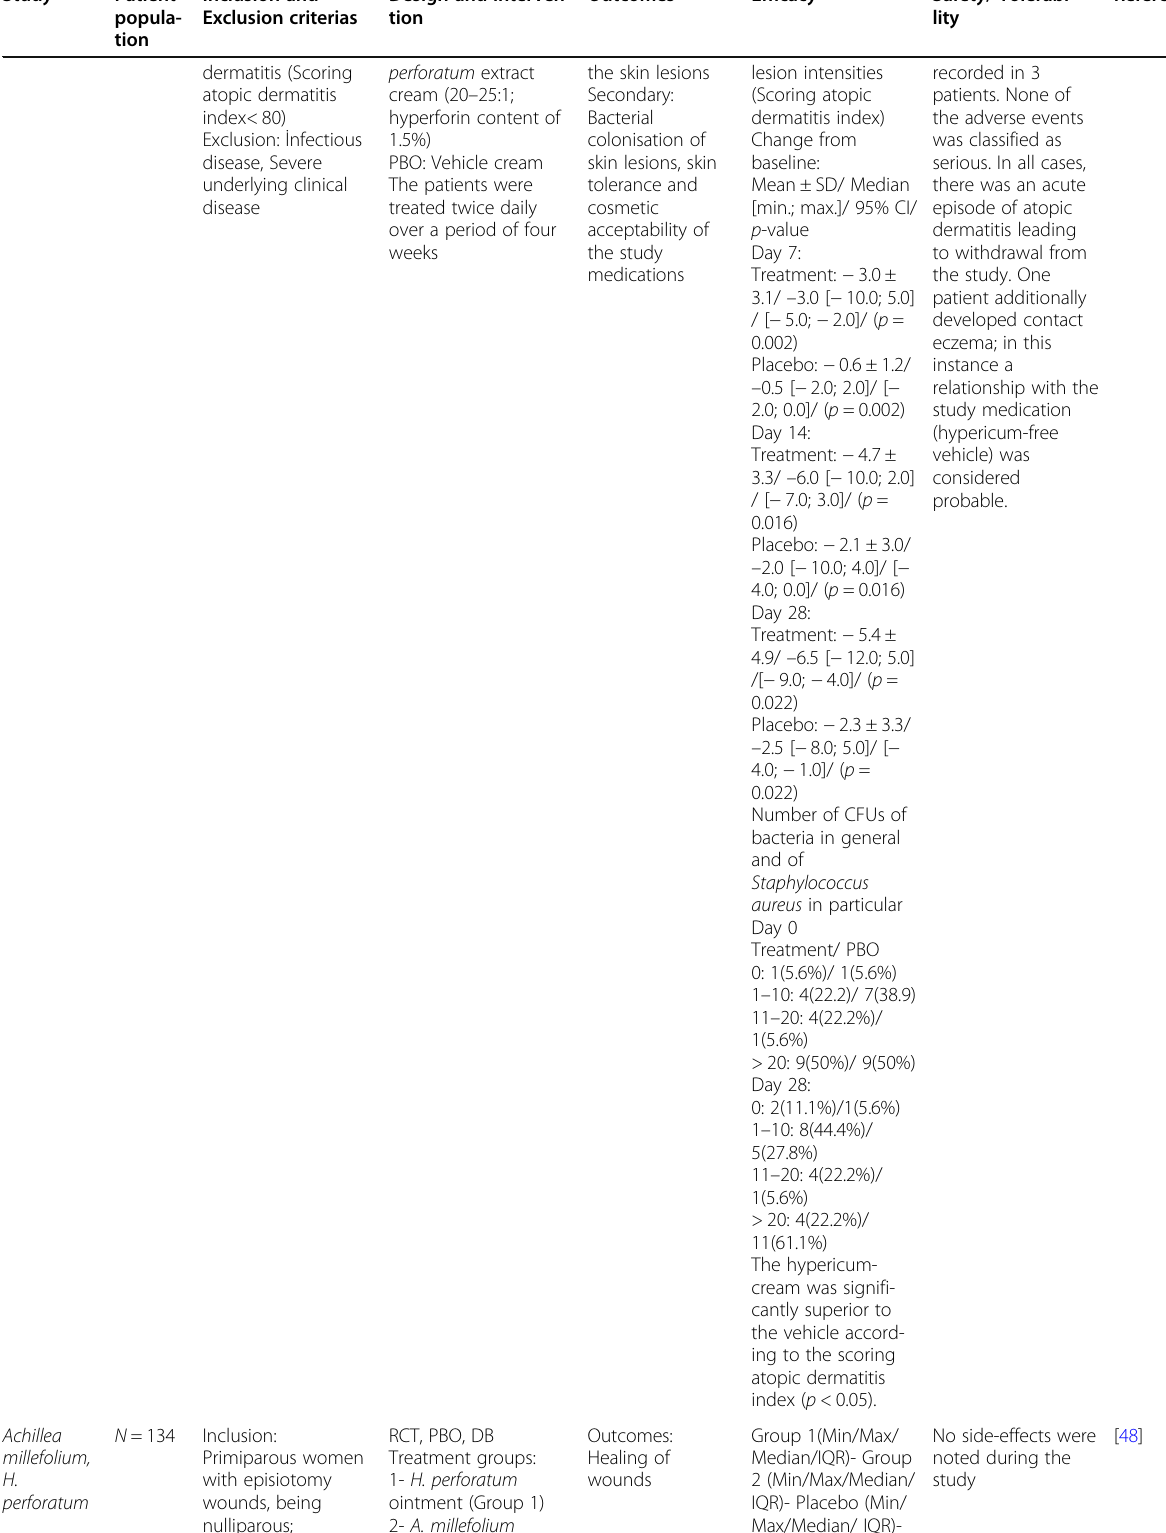
Table 4 Clinical trials of the traditional plants used for skin problems in Turkey (Continued) Study Patient